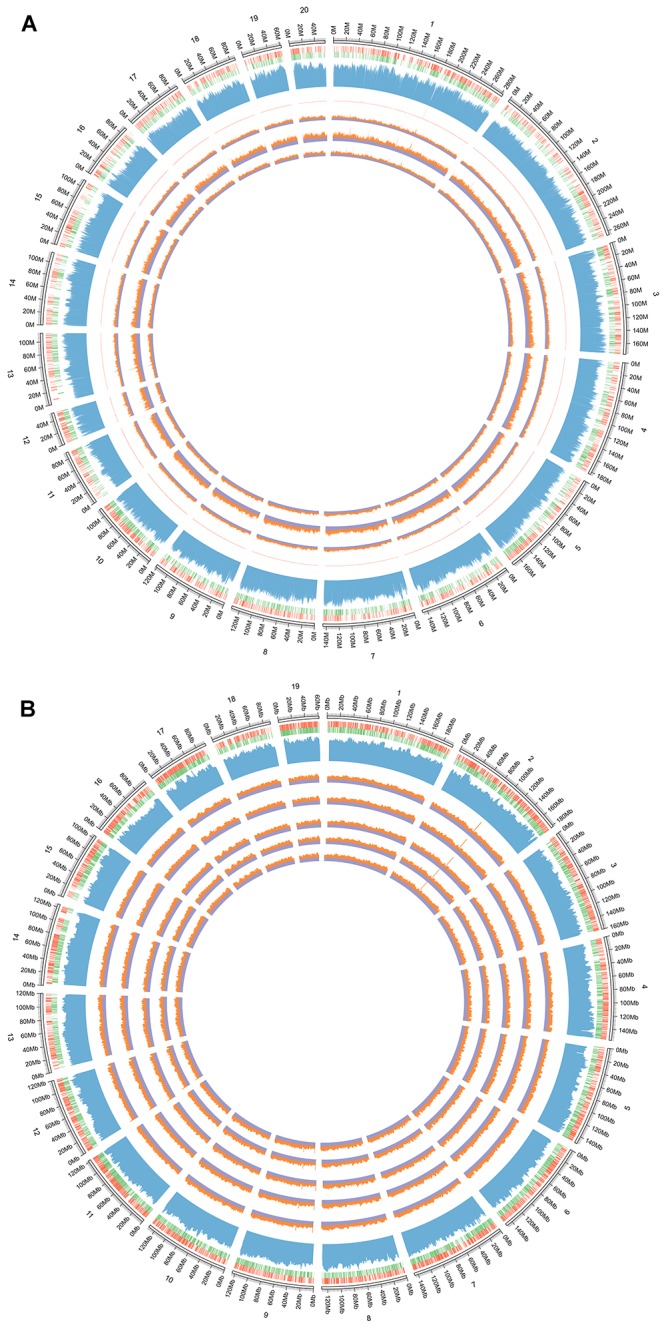
(A) The whole genome methylation circular map of D-galactose induced deficient rats. From the outside to the inner: the first circle is genome; the second circle is the distribution of genome, the red circle is positive chain gene and the green is negative chain gene; the third circle is the distribution of genomic GC content; the fourth is the sequencing depth of all samples; the fifth circle is the control group, the sixth is the AEG-treated group, and the seventh is the model group. Control group that received oral distilled water, model group that received intraperitoneal injection (i.p.) of 100 mg/[kg⋅d] D-galactose, AEG-treated group that received D-galactose (100 mg/[kg⋅d]) + AEG (100 mg/[kg⋅d]). (B) The whole genome methylation circular map of APP/PS1 and SAMP8 mice. From the outside to the inner: the first circle is genome of mice; the second circle is the distribution of genome, the red circle is positive chain gene and the green is negative chain gene; the third circle is the distribution of genomic GC content; the fourth is the SAMP8 model group, the fifth is AEG-treated group on SAMP8 mice, the sixth is the AEG-treated group on APP/PS1 mice, and the seventh is the APP/PS1 model group, the eighth is the control group. Control and model group that received oral distilled water; AEG-treated group at a dosage of 100 mg/[kg⋅d] in AEG, and the extracts were dissolved in distilled water and were given by intragastric administration once daily for 24 weeks, polysaccharide (PEG), alcohol (AEG), and oil (OEG) extracts from G. lucidum by gavage.